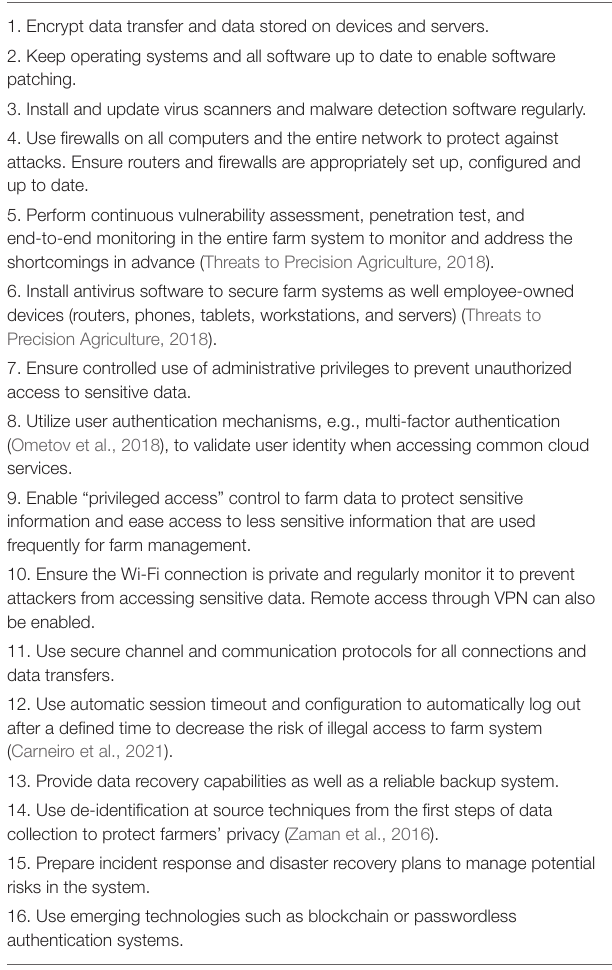
TABLE 2 | Practices that are recommended to ATPs. Security practices recommended to Agricultural Technology Providers